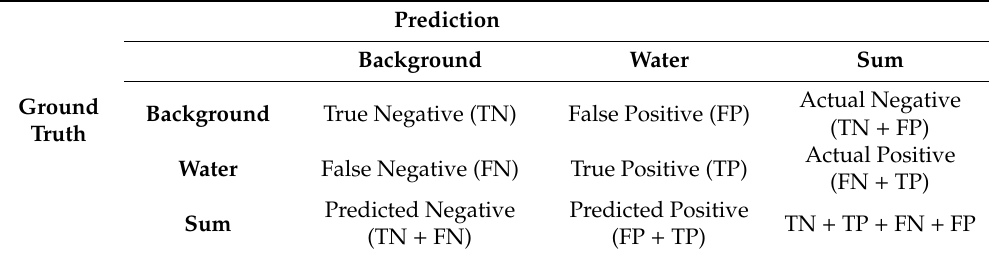
Table 1. Confusion matrix for accuracy